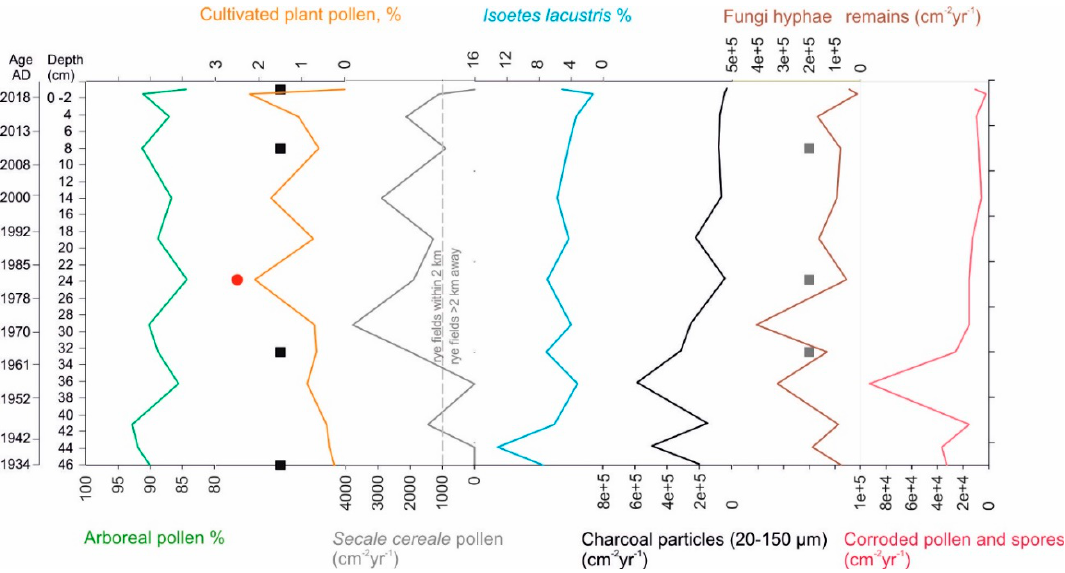
Figure 6. Selection of pollen and non-pollen palynomorphs, from the left: arboreal pollen (%), cultivated plant pollen (%), secale-cereale pollen (cm − 2 yr − 1 ), Isoëtes lacustris (%), charcoal particles (cm -2 yr − 1 ), fungi hyphae remains (cm -2 yr -1 ), and corroded pollen grains and spores (cm − 2 yr − 1 ). The presence of whipworm in the sample is marked with a red circle, the presence of herbivores with black squares and the presence of Glomus spores indicating erosion with grey squares.